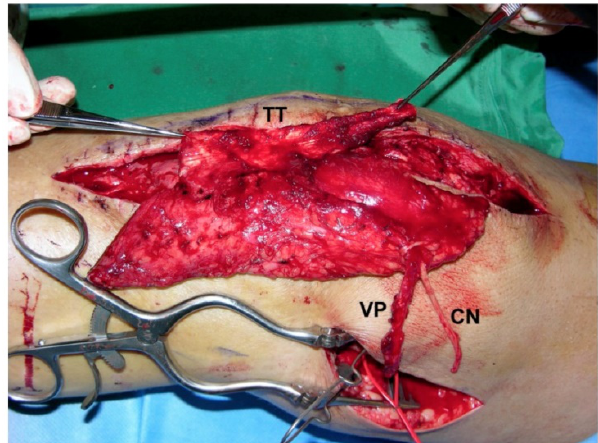
Figure 9: Free s-ELA: Provisional inset of the flap with triceps tendon (TT) held by forceps to reconstruct the patellar tendon defect. An additional incision was needed for microsurgical anastomosis of the vascular pedicle (VP) of the flap to the descending genicular vessels and epineural nerve coaptation of the cutaneous nerve (CN) of the flap to the saphenous nerve (Table 1: Patient No. 3; additional Figures 5, 7, 8, 18, 19).